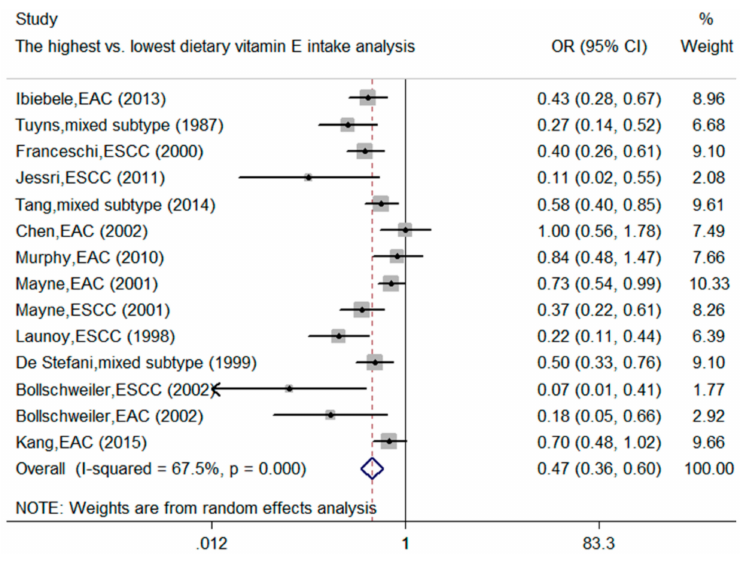
Figure 2. The forest plot for the meta-analysis on dietary vitamin E intake and the esophageal cancer risk. ESCC: esophageal squamous cell carcinoma; EAC: esophageal adenocarcinoma; mixed subtype: did not report the specific subtype of esophageal cancer. Table 2. Overall and subgroup analysis of the association between dietary vitamin E intake and the risk of esophageal